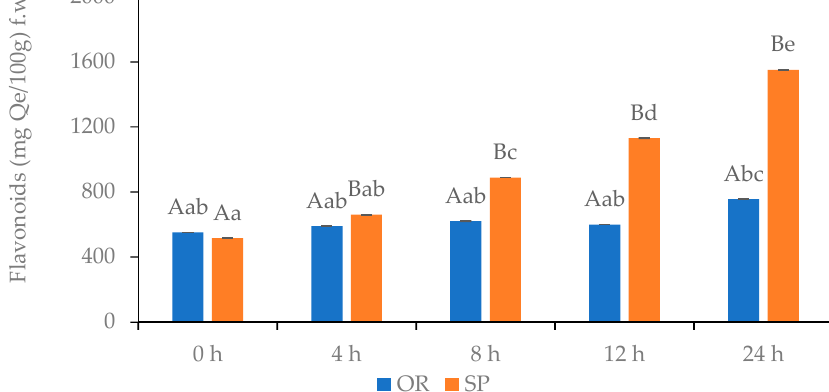
Figure 3. SP and OR total flavonoids content during 24 h of fermentation. Small letters in common indicate no significant differences between OR and SP samples withdrawn at different moments; Big different letters indicate significant differences between SP and OR samples withdrawn at the same moment.